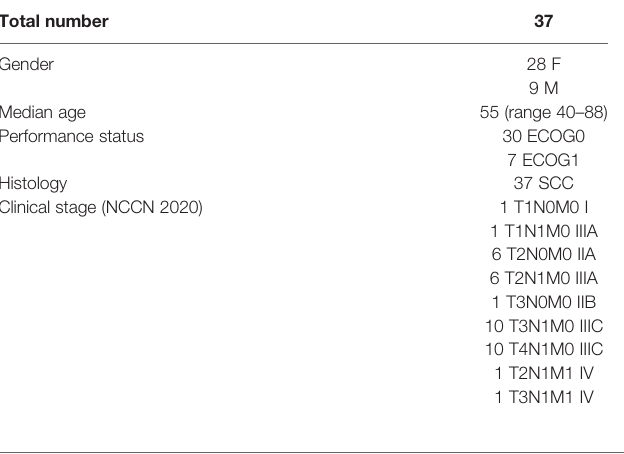
TABLE 1 | Patient and tumor characteristics.